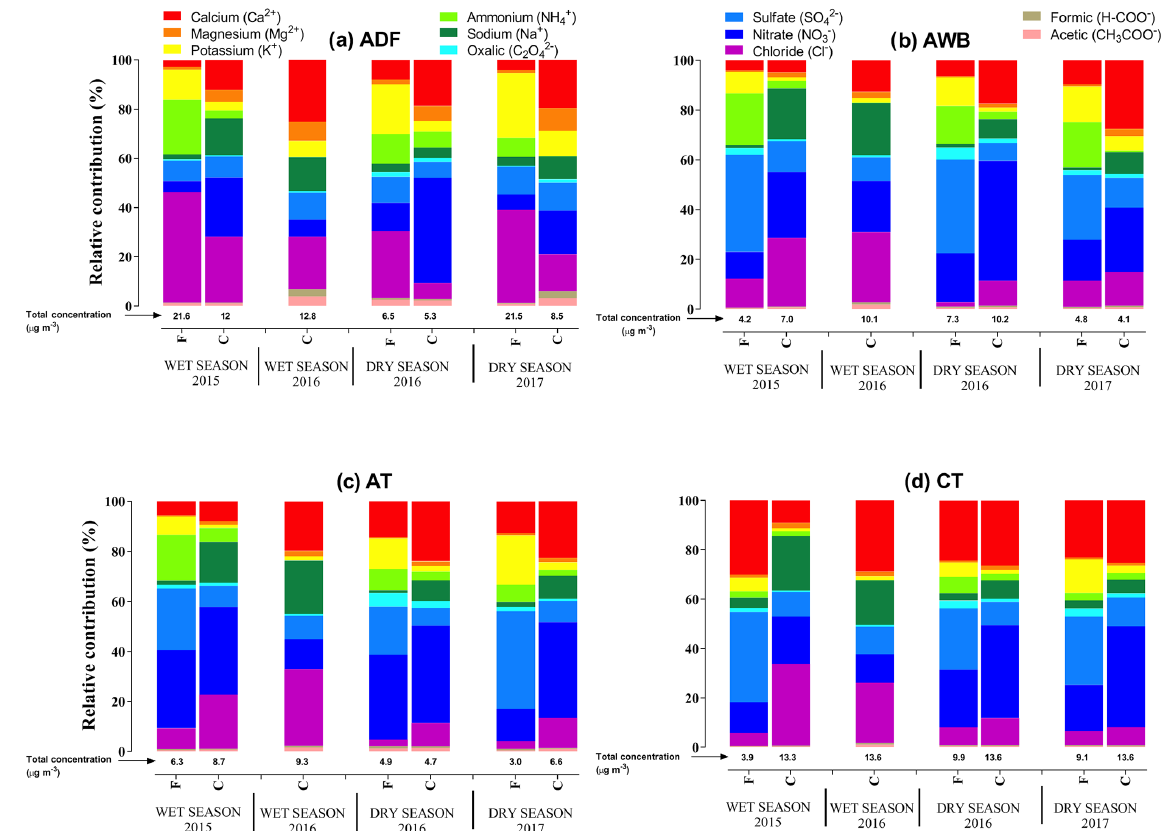
Figure 11. Water-soluble ionic species speciation for each site, each campaign, and each aerosol